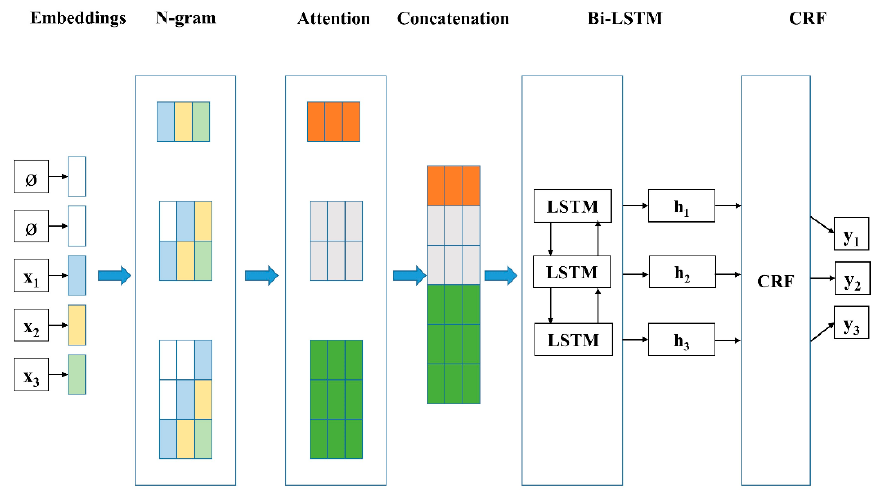
Figure 1. The system architecture of our